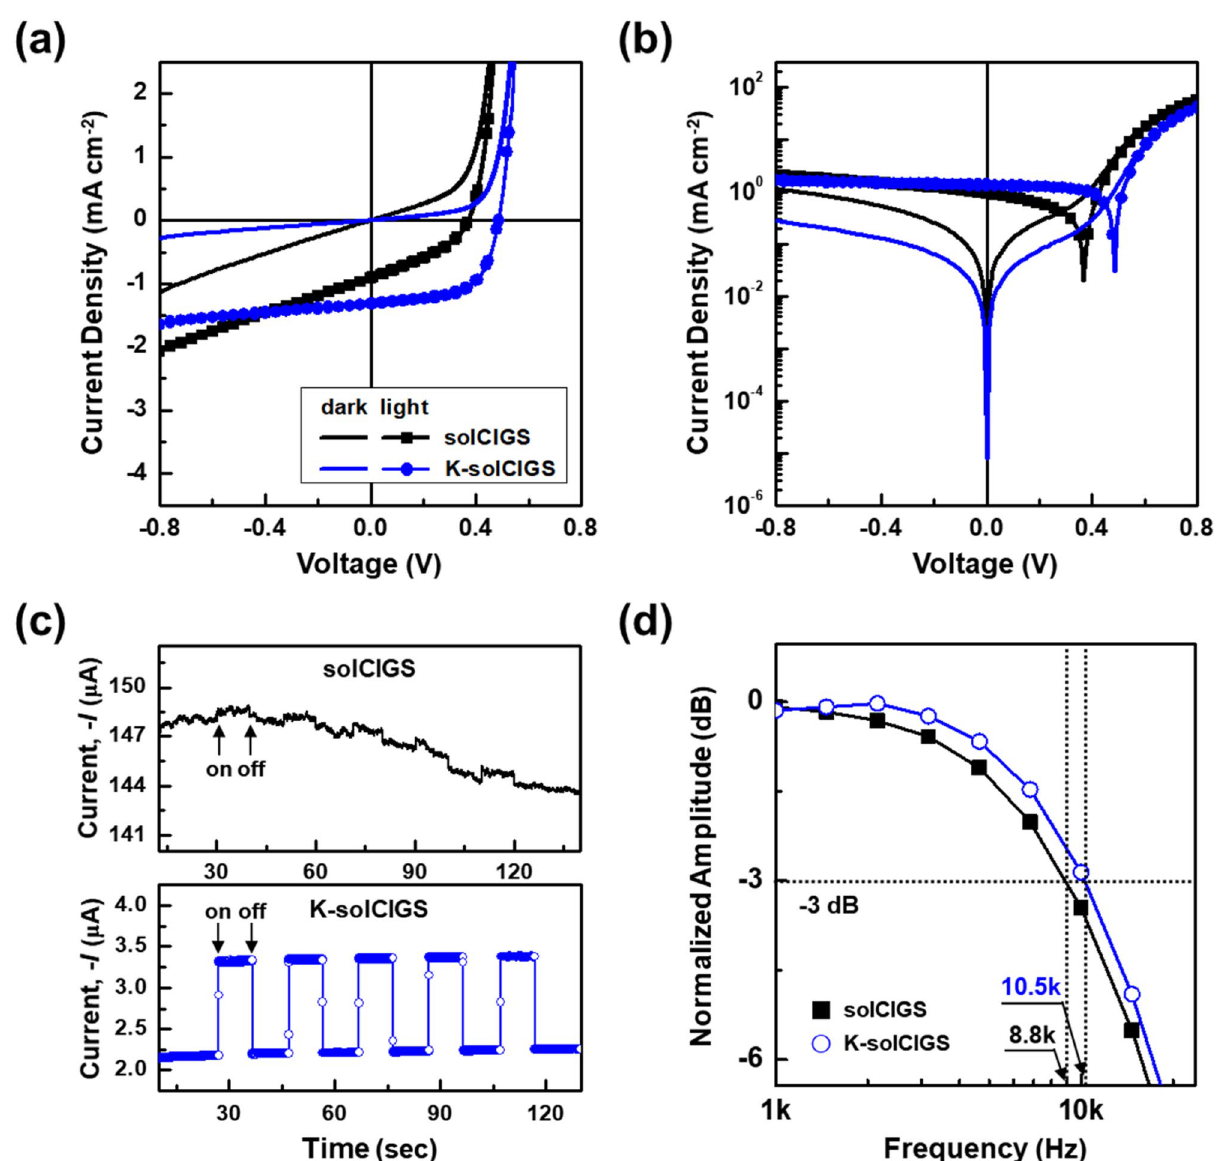
Figure 3. ( a , b ) Current density ‒ voltage ( J ‒ V ) characteristics of solCIGS and K-solCIGS photodiodes in the dark and under illumination at the NIR wavelength of 980 nm ( P IN = 31.4 mW cm −2 ). Note that the graphs in ( a ) and ( b ) show a linear plot and a semi-logarithmic plot of the J ‒ V characteristics, respectively. ( c ) Time- dependent photoresponse of solCIGS and K-solCIGS devices at − 0.4 V ( λ = 980 nm, P IN = 0.03 mW cm −2 ). ( d ) − 3 dB bandwidth comparison of solCIGS and K-solCIGS devices as a function of incident pulse laser frequency under NIR light of 980